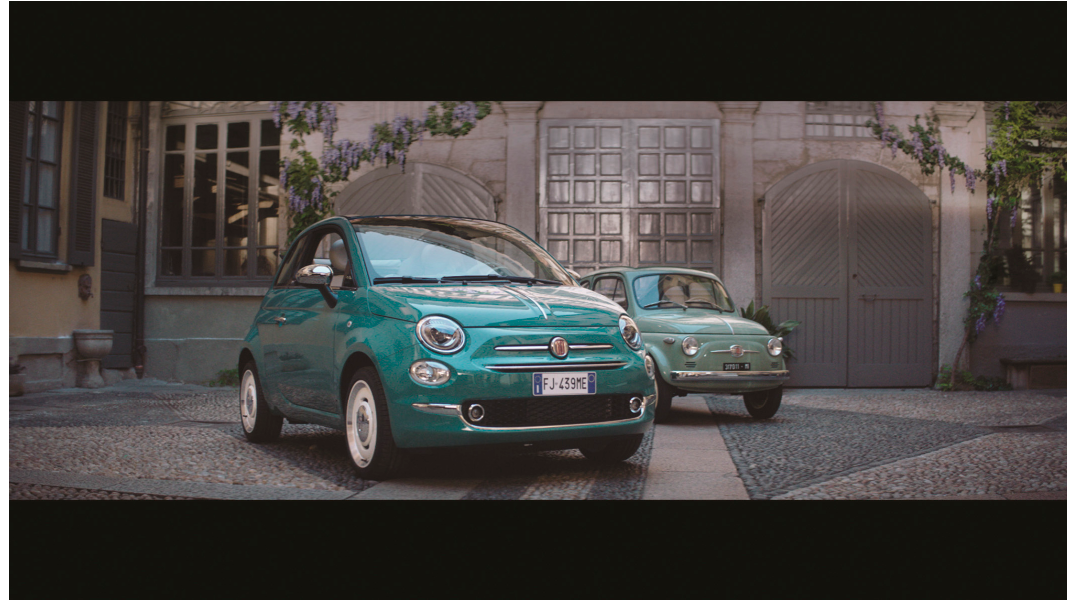
Figure 1. Original and new Fiat Nuova Cinquecento in a frame of See you in the future